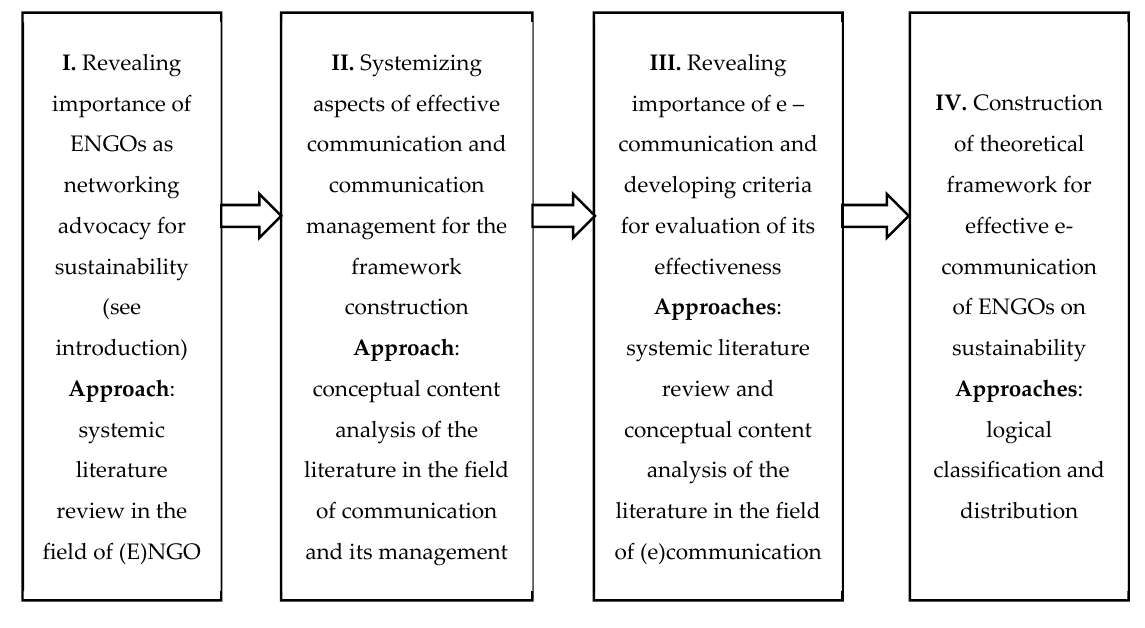
Figure 2. Research design.